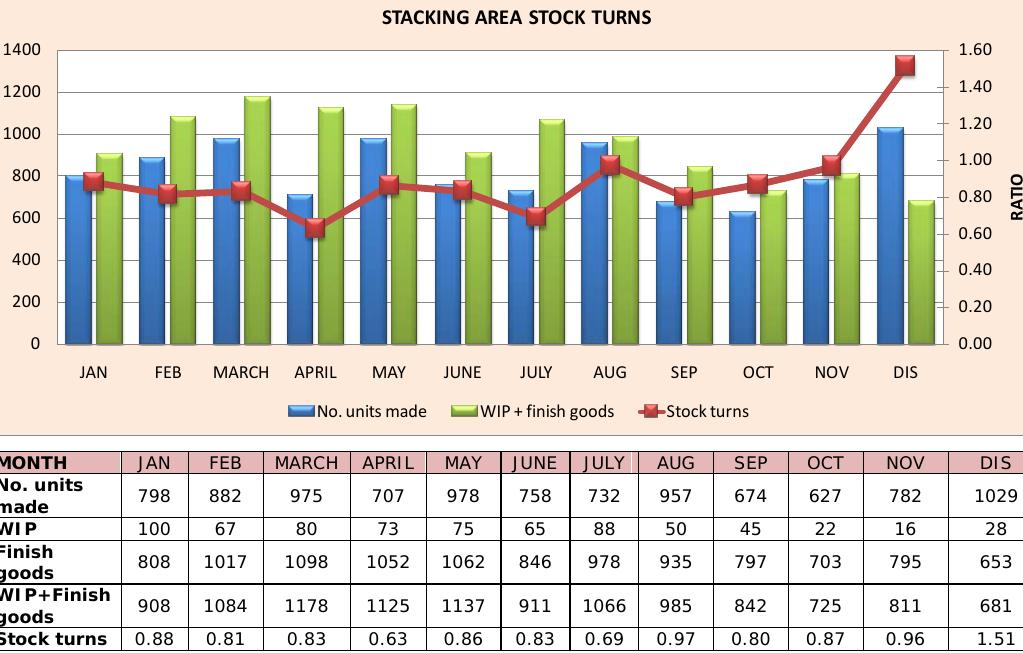
Figure 17. “Stock turn on Kitting department